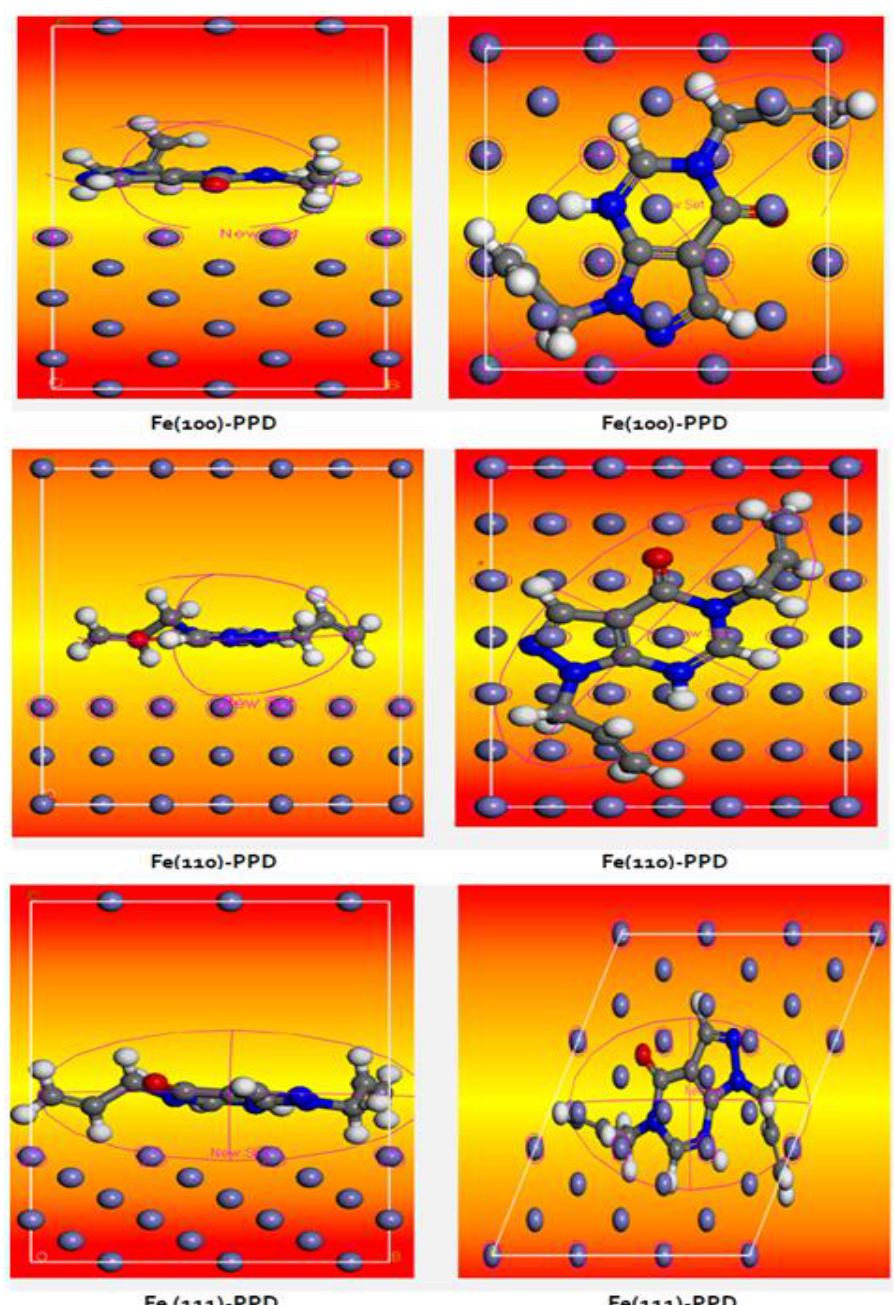
Figure 12. Representative snapshots of the top and side views the PPD/Fe (100), Fe (110) and Fe (111). Table 7. ∆ E adsorption and D energy for {PPD/Fe (100), Fe (110), and Fe (111)} interfaces.